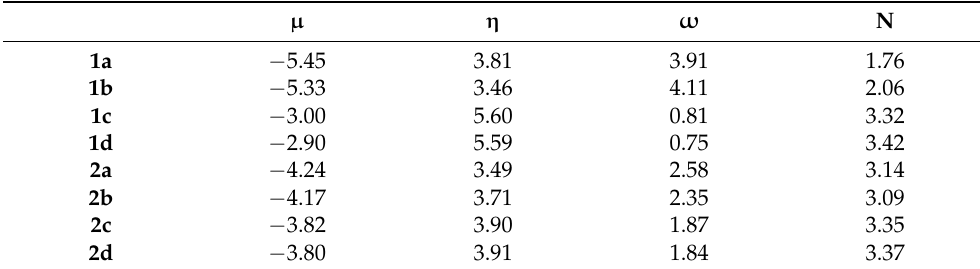
Table 1. Global electronic properties (electronic chemical potential µ , chemical hardness η , global electrophilicity ω , and nucleophilicity N; all in eV) for the studied